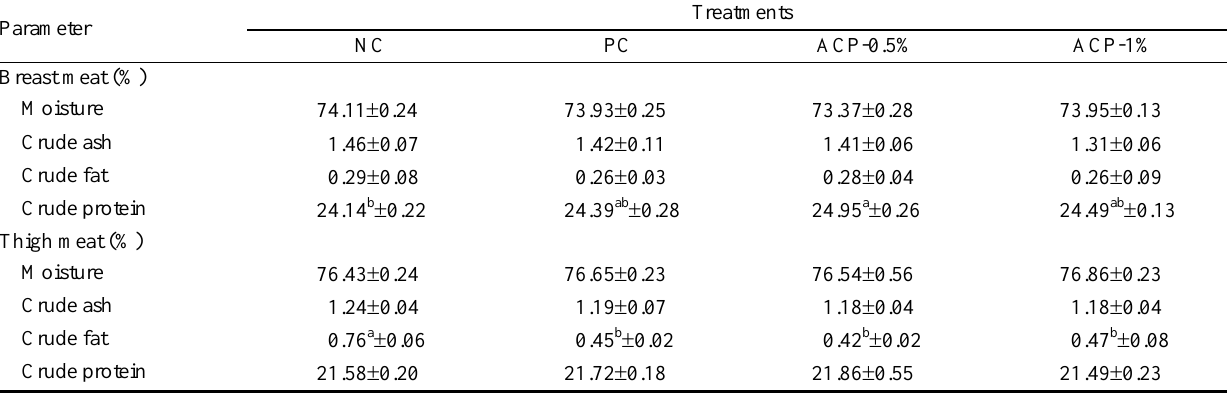
Table 4. Effect of Alisma canaliculatum with probiotics on broiler meat composition (n = 15 for each treatment)